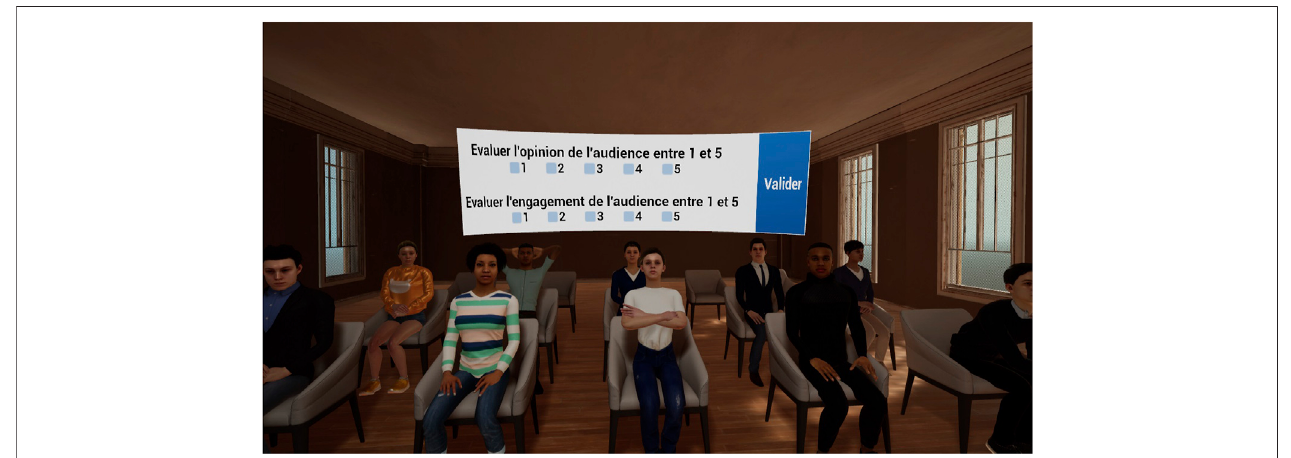
FIGURE 7 | Participant ’ s view during the audience perception evaluation.